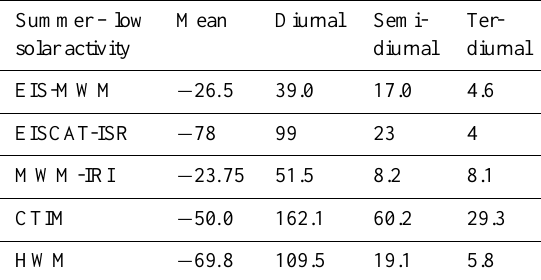
Fig. 2. As for Fig. 1 but for summer season, low solar activity. Table 2. As for Table 1 but for summer season, low solar